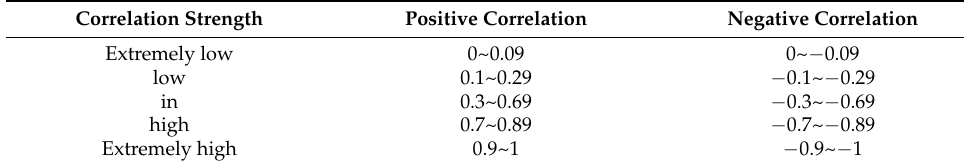
Table 2. Pearson correlation coefficient comparison table.